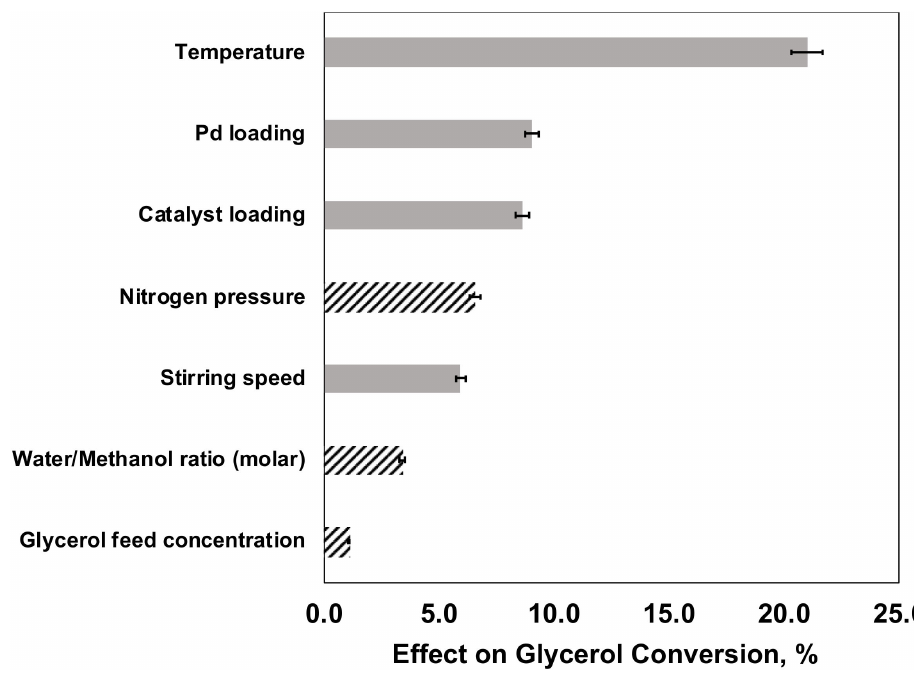
Figure 9. The effects of single factor on glycerol conversion. (Solid bars) positive effects; (patterned bars) negative effects; error margin: 95% confidence